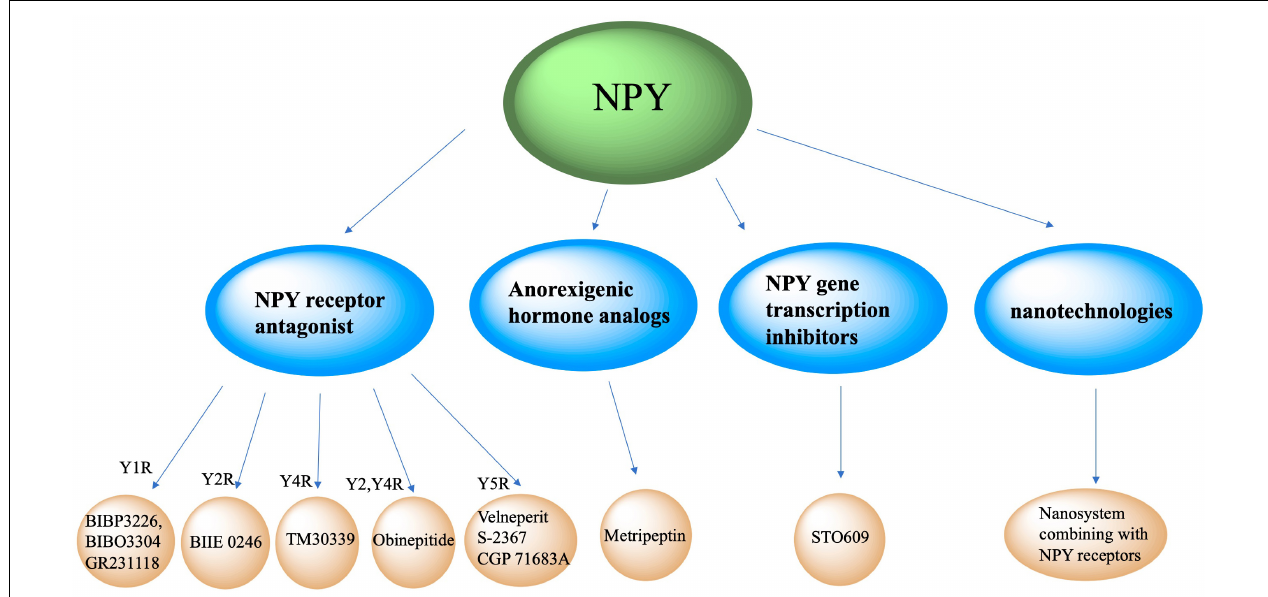
FIGURE 4 | Clinical therapeutic intervention strategy of NPY. Intervention strategies targeting NPY include NPY receptor antagonists, anorexigenic hormones analogs, NPY gene transcription inhibitors and new technologies like